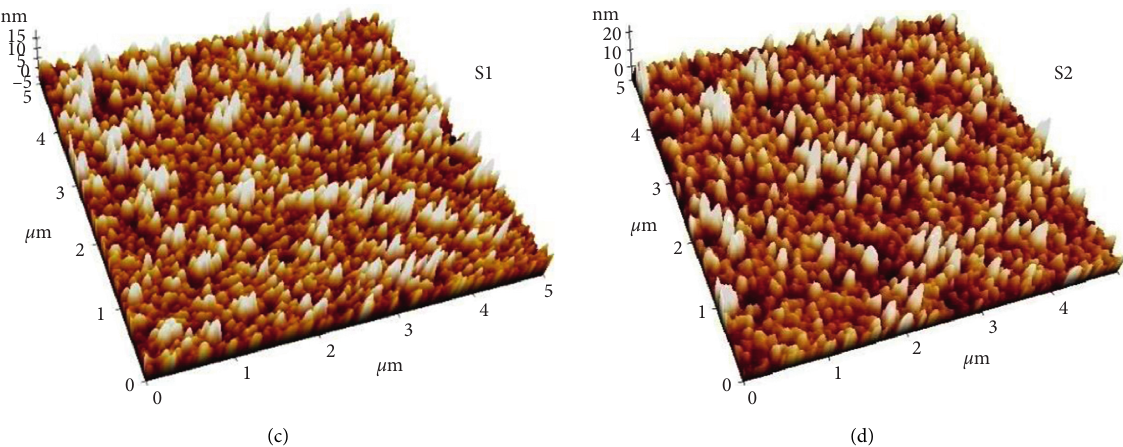
Figure 3: Surface morphology (3D view 5 × 5 μ m) of TiZrN/TzZrN deposited at different temperatures: ((a), (c)) 200 ° C and ((b), (d)) 400 o C.